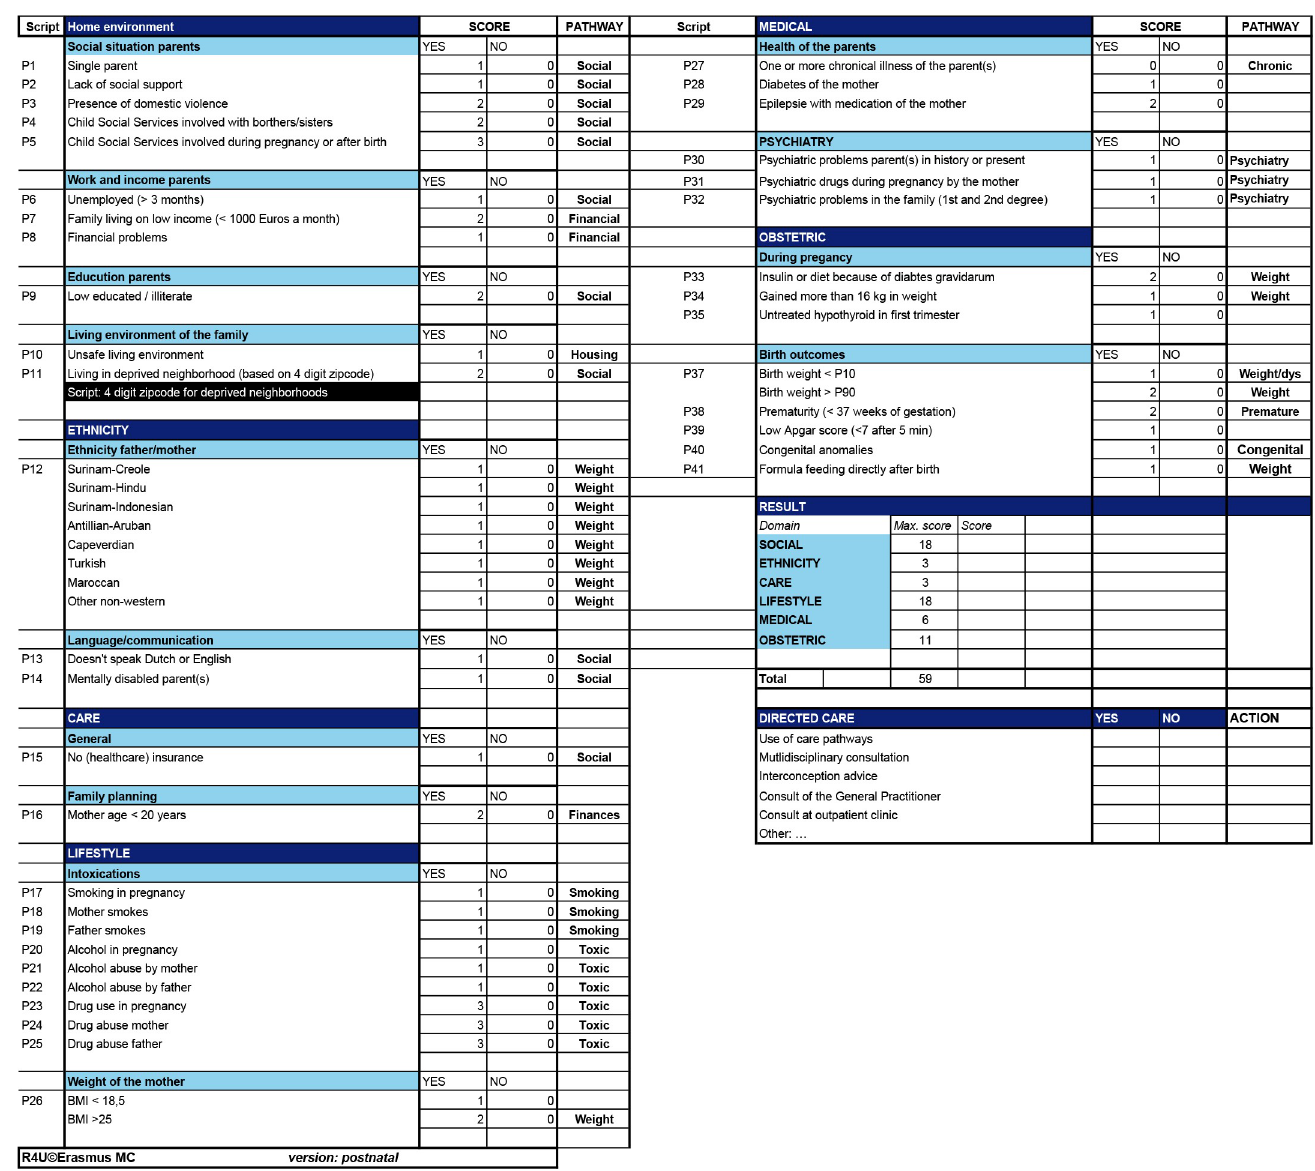
Fig 3. Postnatal R4U: Presenting risk factors (second column), the corresponding score (column 3 and 4) and care pathway(s) (column 5).